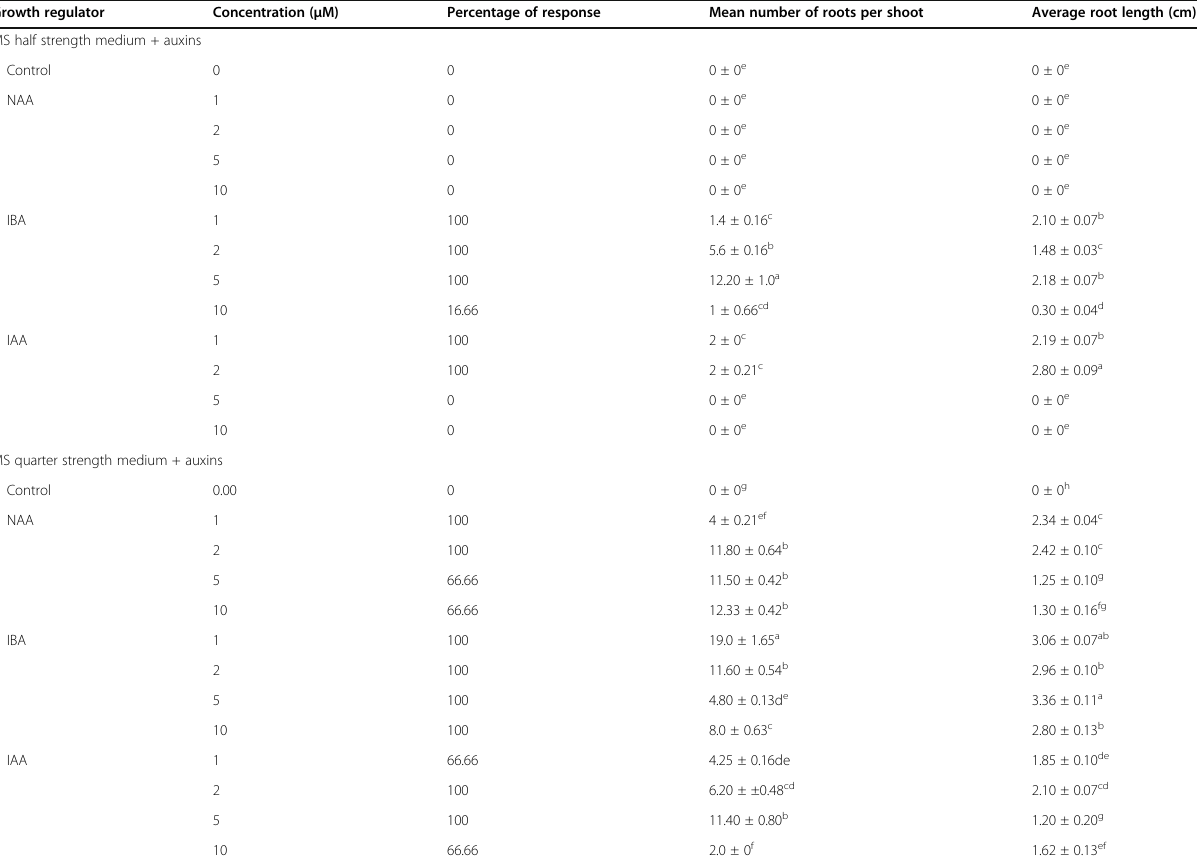
Table 2 Effect of auxins supplemented MS medium on induction of roots from the shoots of Andrographis alata Growth